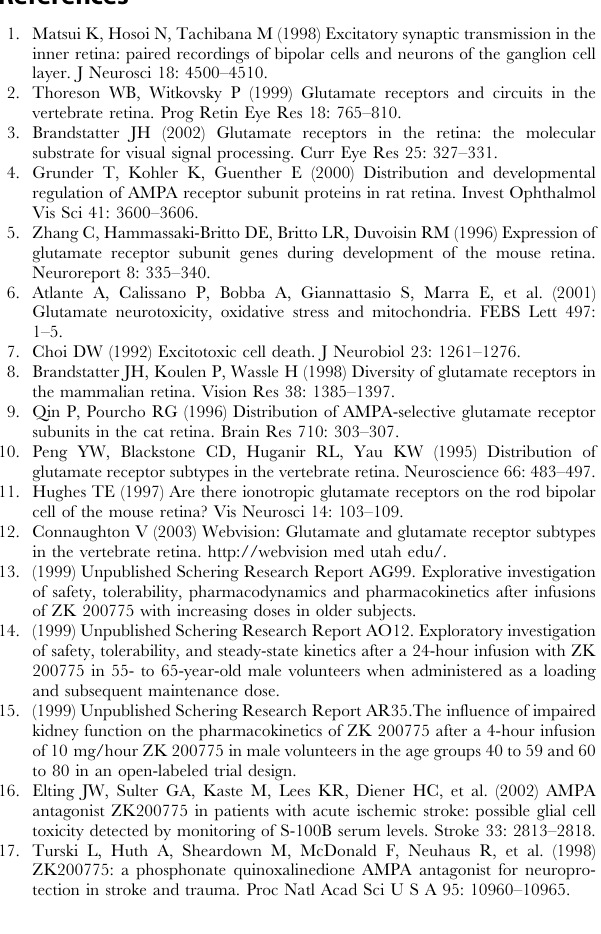
Table S3 Eye Motility. Data for both eyes and each group before infusion and 4 and 22 hours after infusion of ZK 200775. No significant changes occurred.